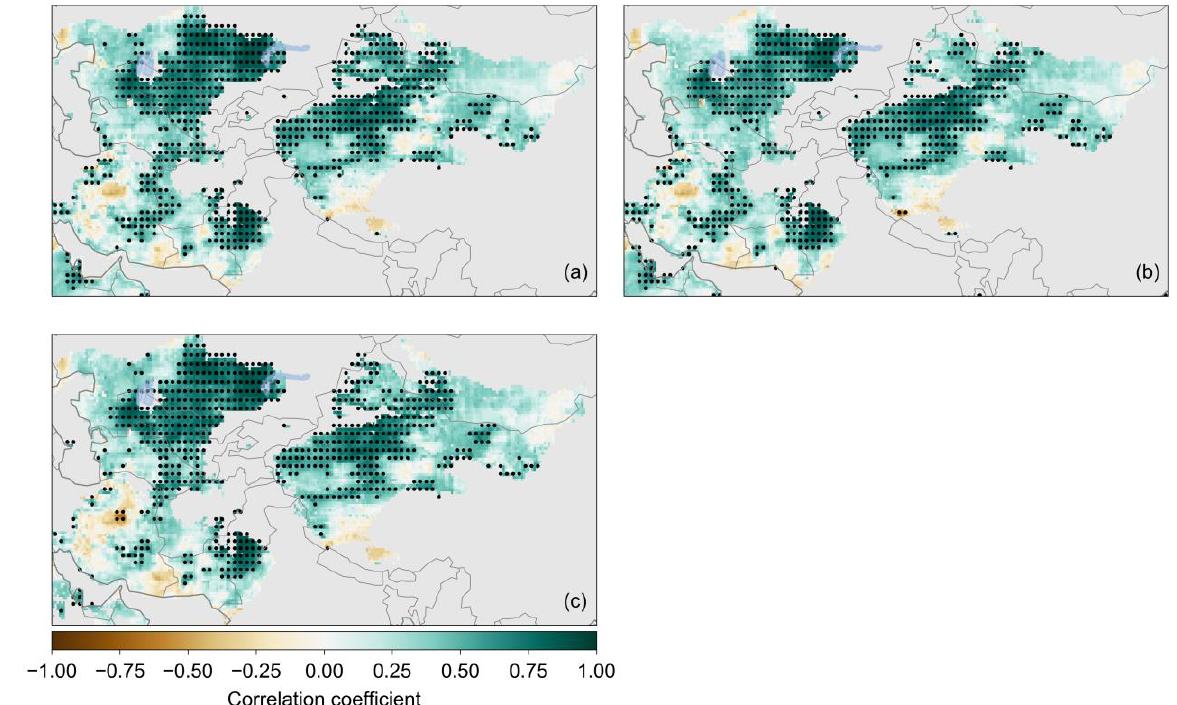
Figure 3. Correlation coefficients between ET in the Asian arid regions and global SST anomalies during the 2003-2017 period. (a): total ET, (b): evaporation from bare soil (Eb), (c):